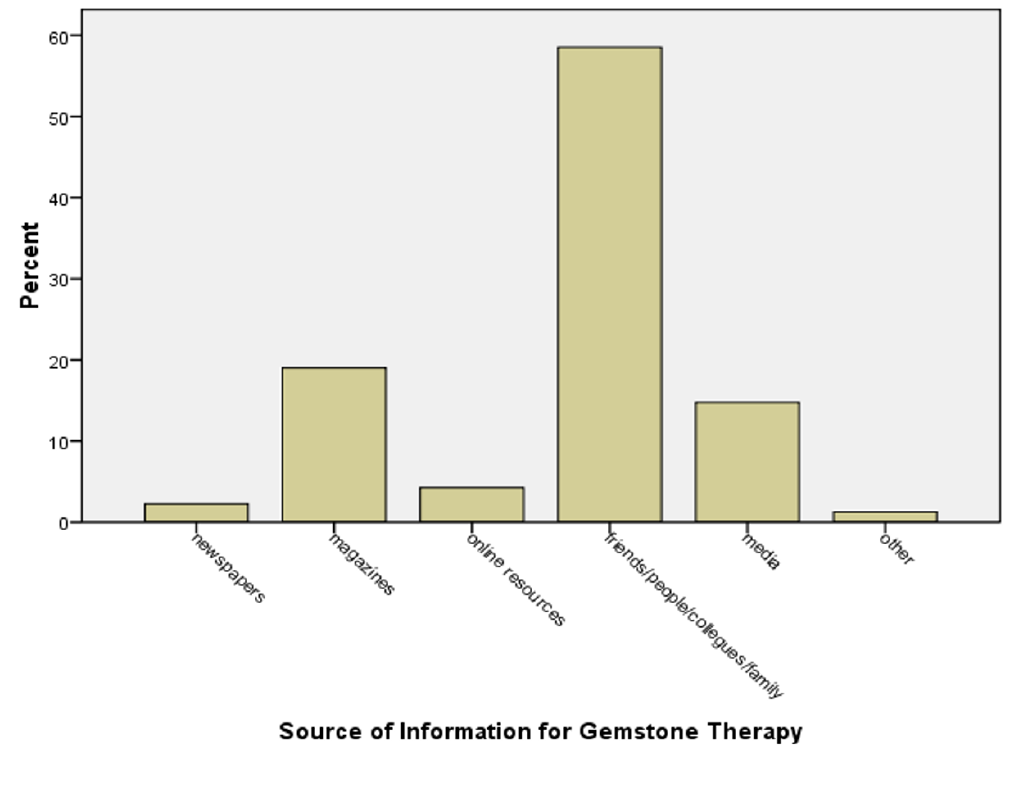
Figure 1 Source of Information for Gemstone Therapy